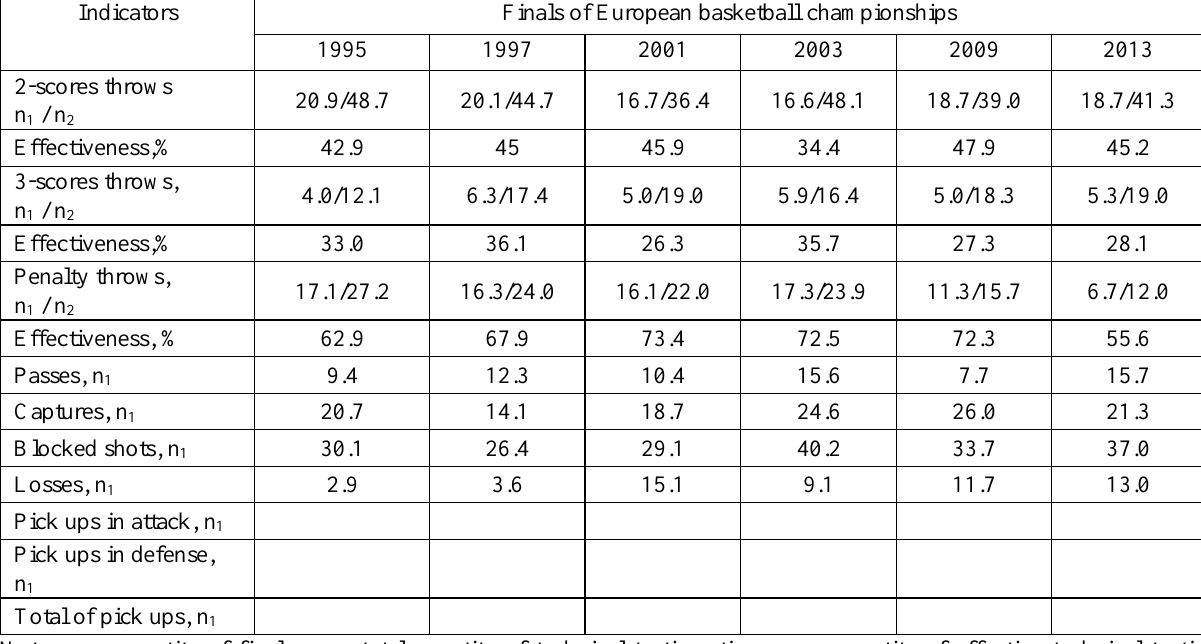
Averaged indicators of competition functioning of basketball combined team of Ukraine (women) in finals of European